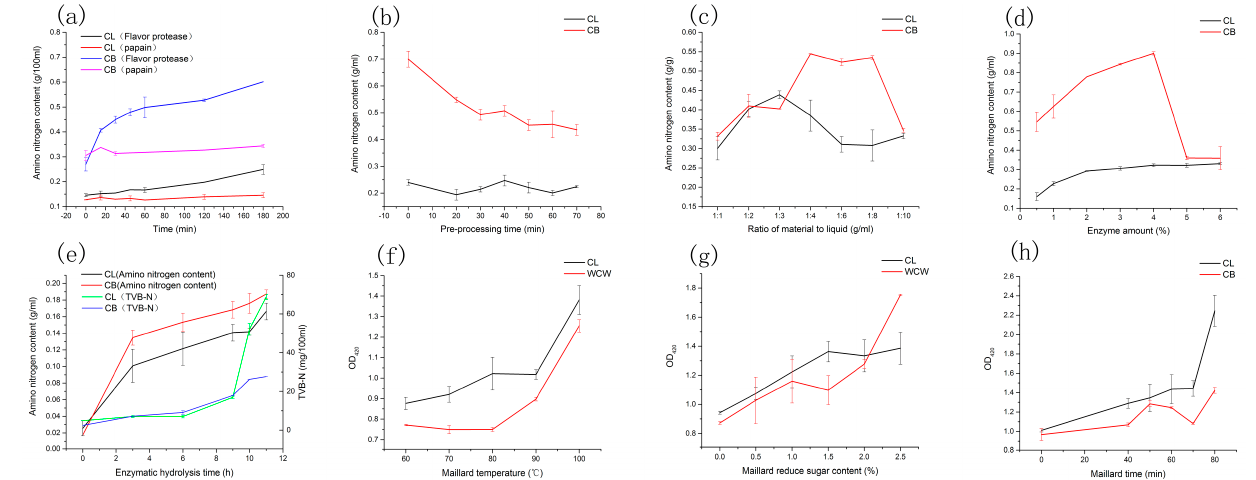
Figure 1. Ptimiziation of the enzymatic and Maillard process conditions: ( a – e ) Optimization of the enzymatic process conditions: ( a ) the choice of enzyme species, ( b ) pre-processing time, ( c ) ratio of material to liquid, ( d ) enzyme amount, and ( e ) time of enzymatic hydrolysis. ( f – h ) Optimization of the Maillard process conditions: ( f ) the Maillard temperature, ( g ) Maillard-reduced sugar content, and ( h ) Maillard